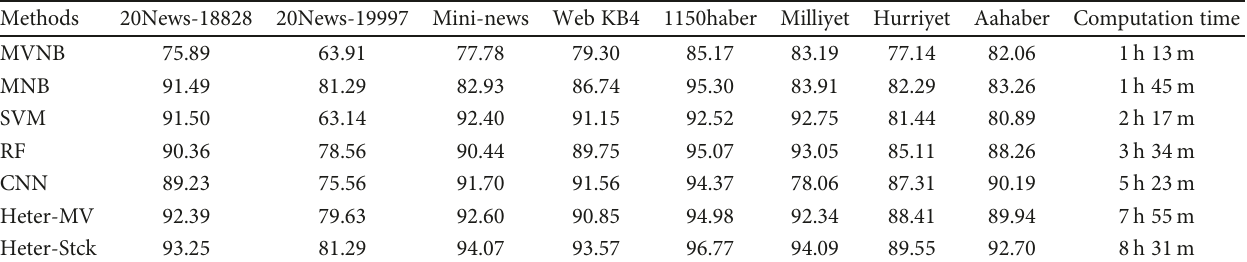
Table 3: The list of classi fi cation accuracies of single classi fi ers and heterogeneous ensemble systems with majority voting and stacking integration strategies on datasets represented with TF-IDF